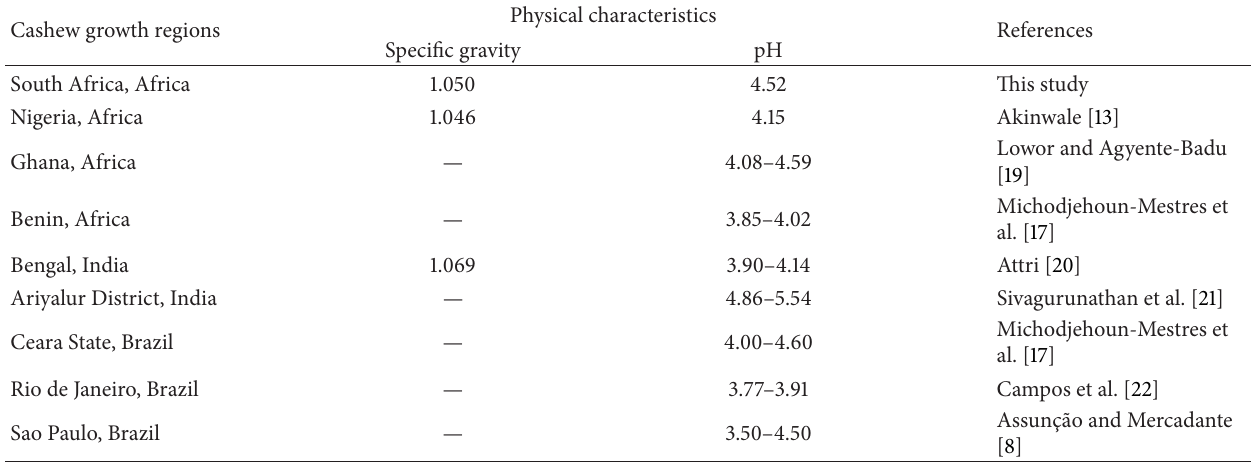
Table 2: Physical compositional characteristics of cashew apple juice.